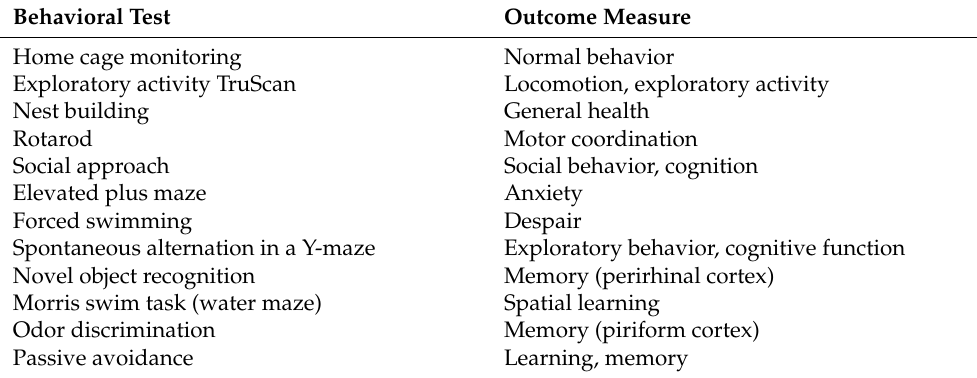
Table 3. Summary of behavioral tests used in this